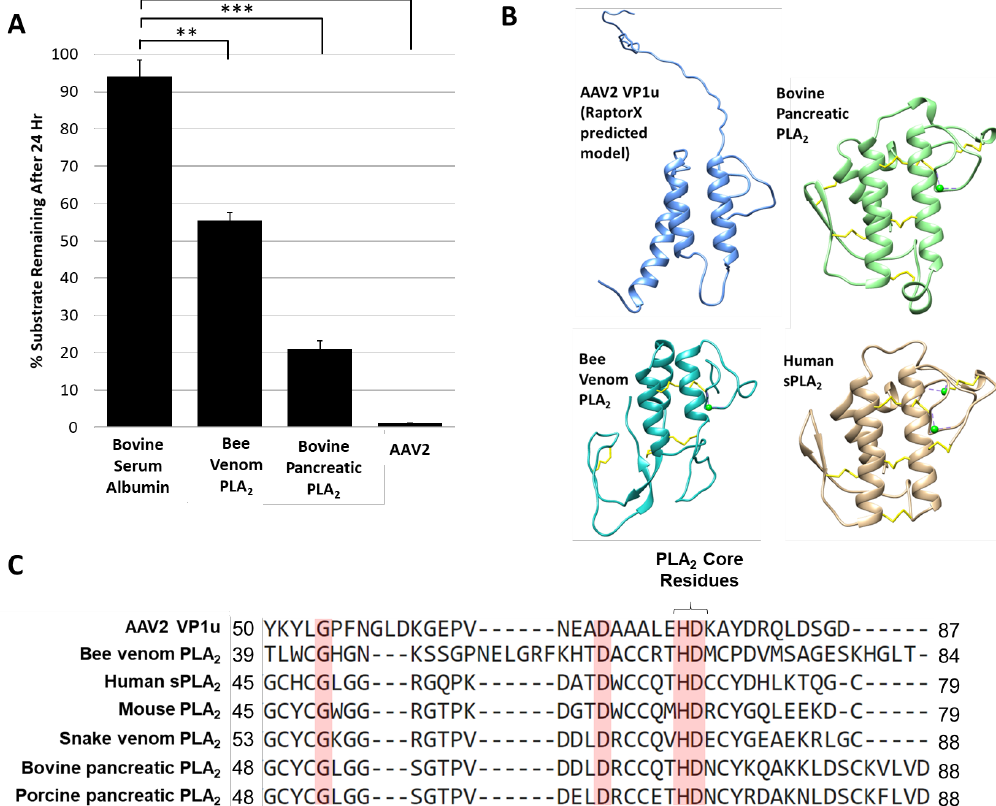
Figure 5. Protease activity is a general property of PLA 2 enzymes: ( A ) Quantification of casein substrate degraded by bee venom PLA 2 , bovine pancreatic PLA 2 and AAV2. The y - and x -axes are as described in Figure 4. ( B ) Predicted structure of AAV2 VP1u compared to bee venom PLA 2 (PDB ID: 1POC), bovine pancreatic PLA 2 (PDB ID: 1UNE) and human sPLA 2 (PDB ID: 1KQU). ( C ) Partial amino acid sequence alignment of PLA 2 enzymes (conserved residues are highlighted in red). Statistical significance as indicated by asterisk annotations (*) are described in Material and Methods